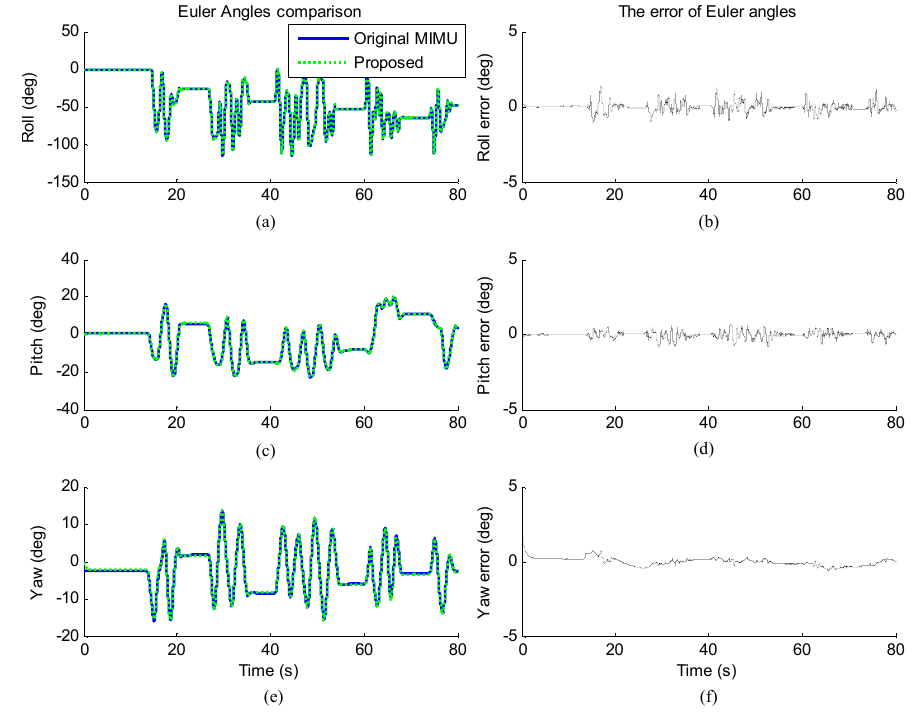
Figure 9. The orientation estimated by original MIMU algorithm (solid) and proposed method (dotted) in dynamic state. ( a , c , e ) Euler angles; ( b , d , f ) The error of Euler angles.